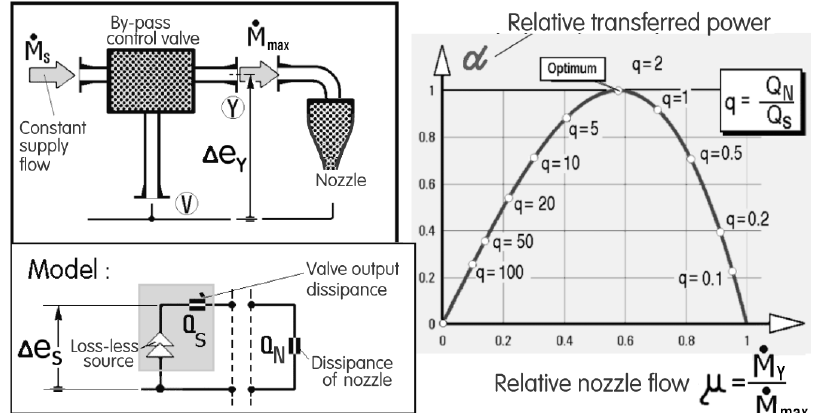
Fig. 12 . An example of matching the nozzle, characterised by its dissipance Q N , and its fluid supplying valve with output dissipance Q S . The ratio of the two dissipances q is related in the unique manner to the ratio of supplied and by-passed flow rates, the dependence exhibiting an optimum for transferring maximum fluid power (product of mass flow rate and specific energy